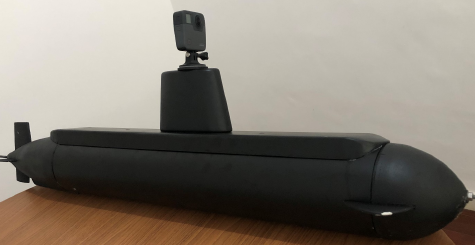
Figure 3. Our developed probe carrier mockup with a 360 ◦ camera mounted at the top of